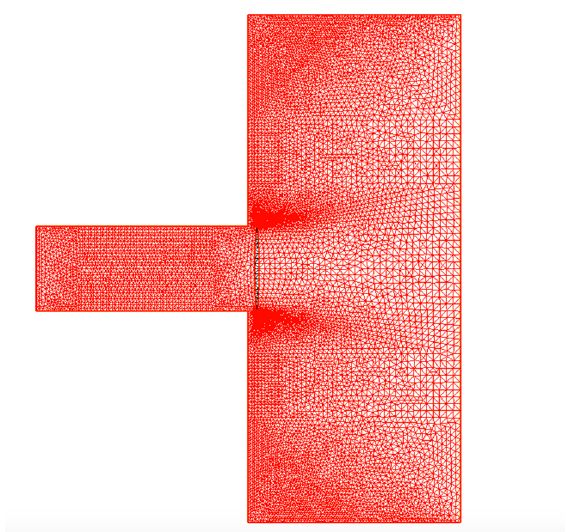
Figure 3. Case 1: valve operative condition with h = 3 mm; numerical model mesh for the scheme reported in Figure 2.